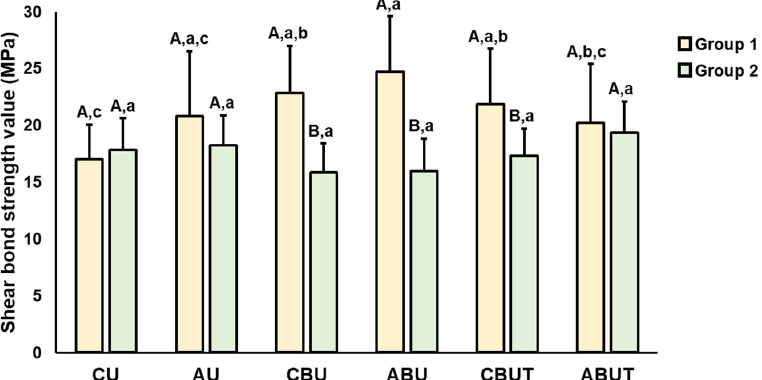
Figure 4. Results of the SBS between Groups 1 and 2 before thermocycling. Uppercase letters indicate significant differences between Groups 1 and 2 within the same adhesion condition, while lowercase letters indicate significant differences between adhesion conditions within each group.